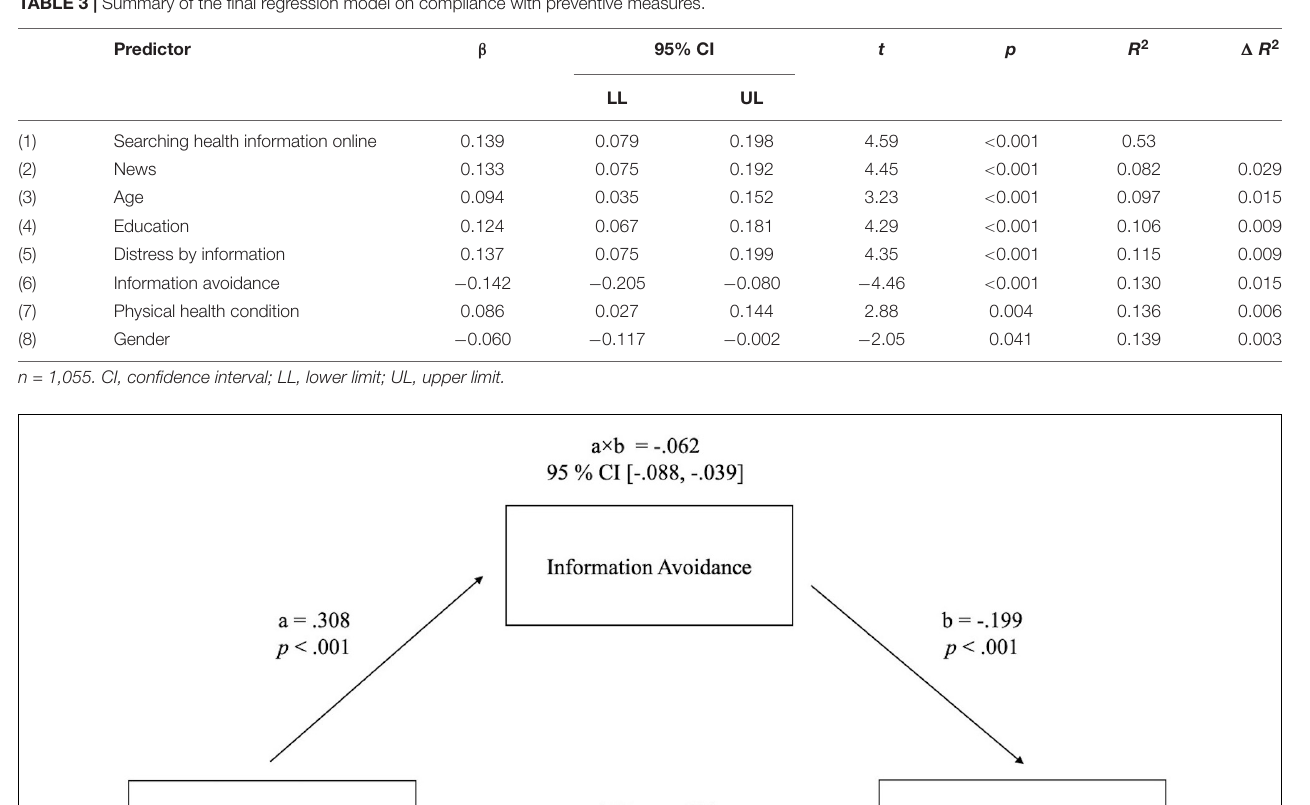
TABLE 3 | Summary of the final regression model on compliance with preventive measures.